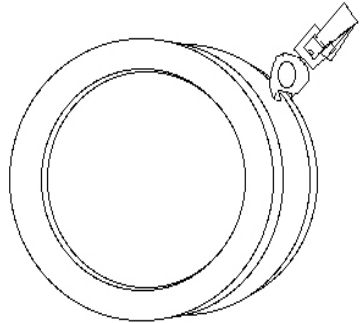
FIGURE 4. All season comparison results between PASS SO 2 and a continuously SO 2 analyzer in EIMU Canada from June 1996 to June 1997. Independent